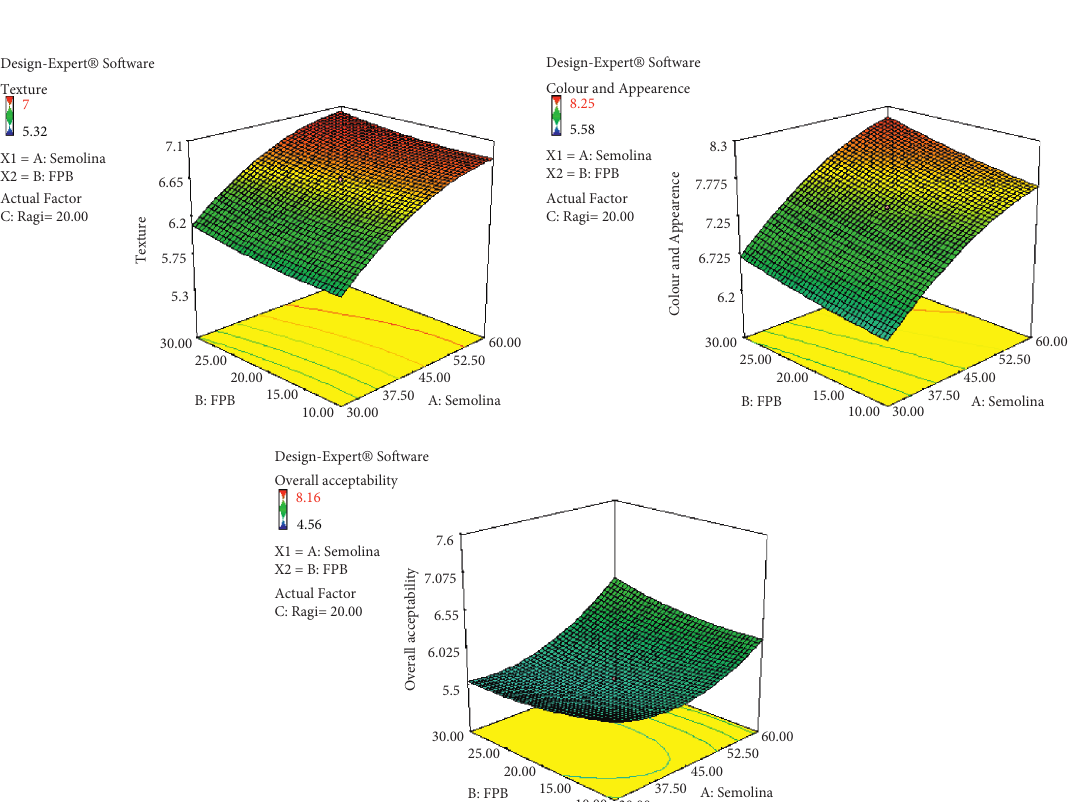
Figure 1: Three-dimensional (3D) surface plot indicating cumulative effects of the independent variables ( A � semolina, B � FPB, and C � finger millet) on the response variables, viz, sensory parameters such as texture (a), colour and appearance (b), and overall acceptability (c) of fruit peel macaroni.